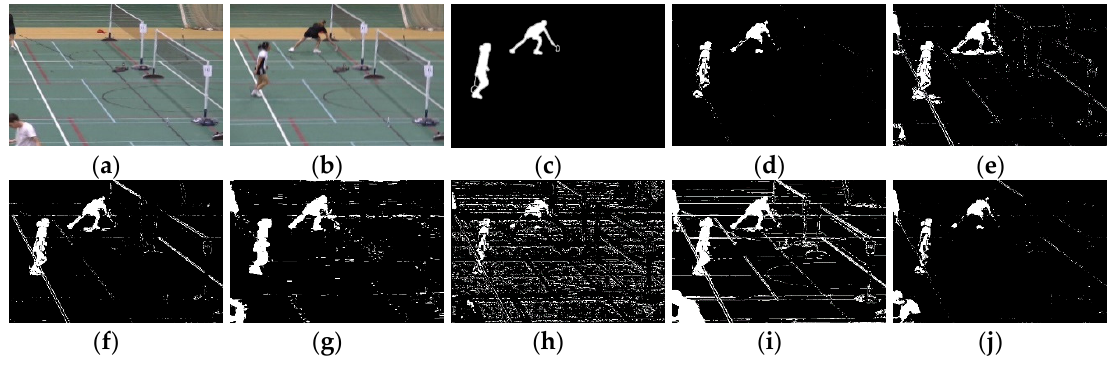
Figure 11. Comparison of segmentation results of seven background subtraction methods for one frame taken from the badminton sequence. ( a ) Frame n (start image), ( b ) frame n + 99, ( c ) ground-truth, ( d ) EBBE (proposed), ( e ) codebook, ( f ) GMM, ( g ) KDE, ( h ) PBBE, ( i ) SOBS, and ( j ) ViBe.